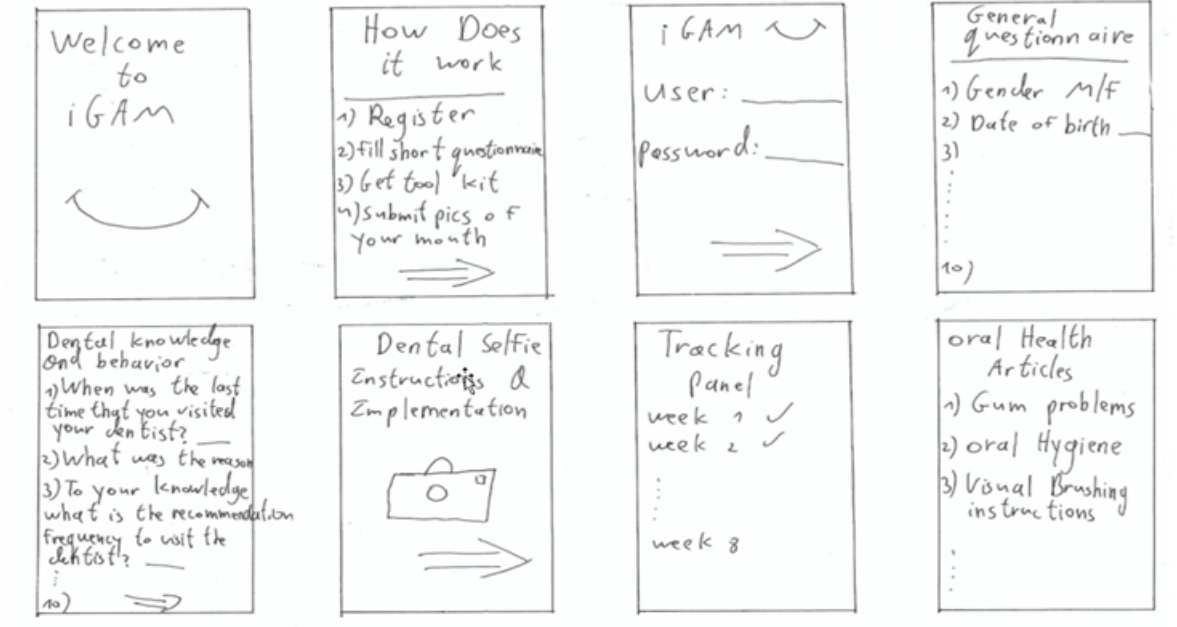
Figure 4. Sketches of the essence of the